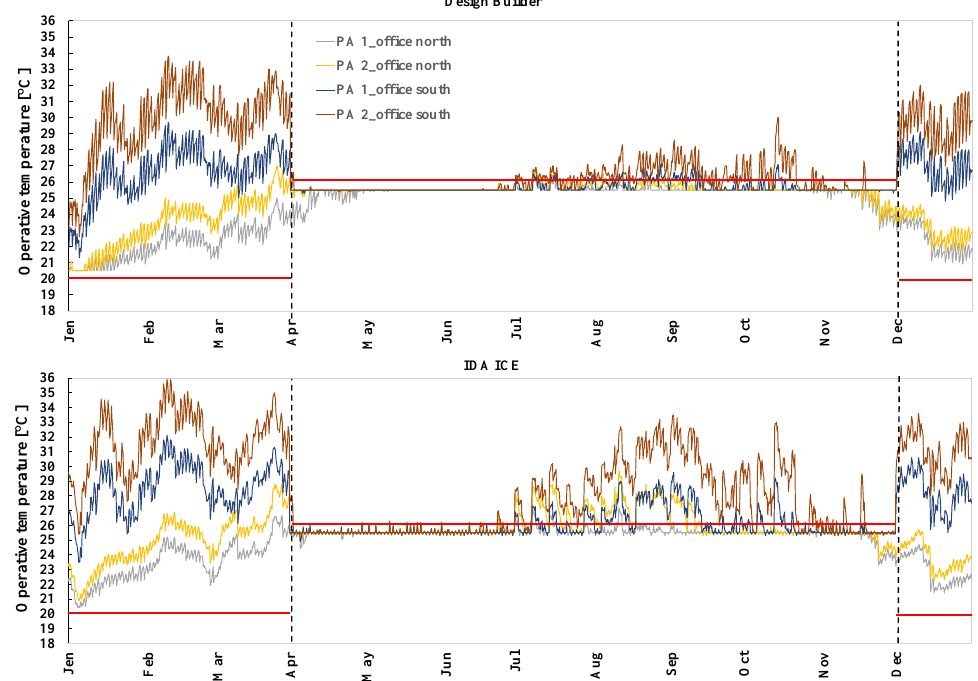
Figure 3. Operative temperature for Palermo in Design Builder (up) and IDA ICE (down). Dashed black lines are the limits of the seasons (winter/summer) and the red lines are the limits of the ranges of thermal comfort according to standard EN 16798-1 [8] for the heating and cooling season. PA 1: Palermo/scenario 1, PA 2: Palermo/scenario 2.